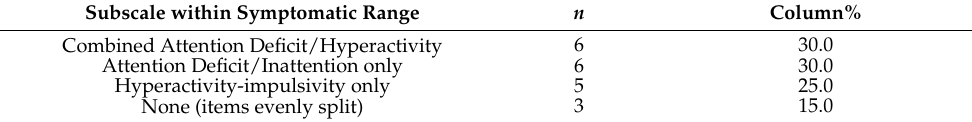
Table 2. Subscale breakdown among adults with FD endorsing AD/H symptoms ( n = 20). Subscale within Symptomatic Range n Column% Combined Attention